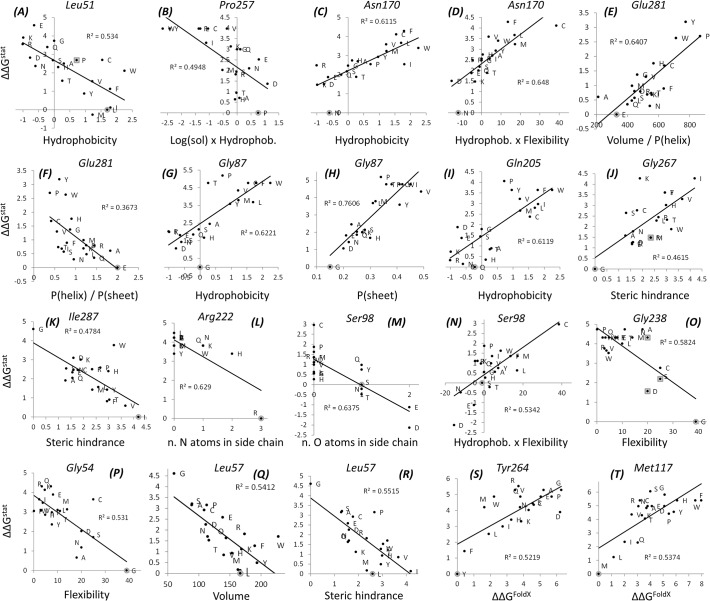
Examples of correlations detected between ΔΔGstat values and amino acid descriptors (a-r) or ΔΔGFoldX (s-t).The gray circles point at the wild type amino acid, gray squares point at substitutions that have been observed in natural TEM variants. Lines correspond to best linear fits.